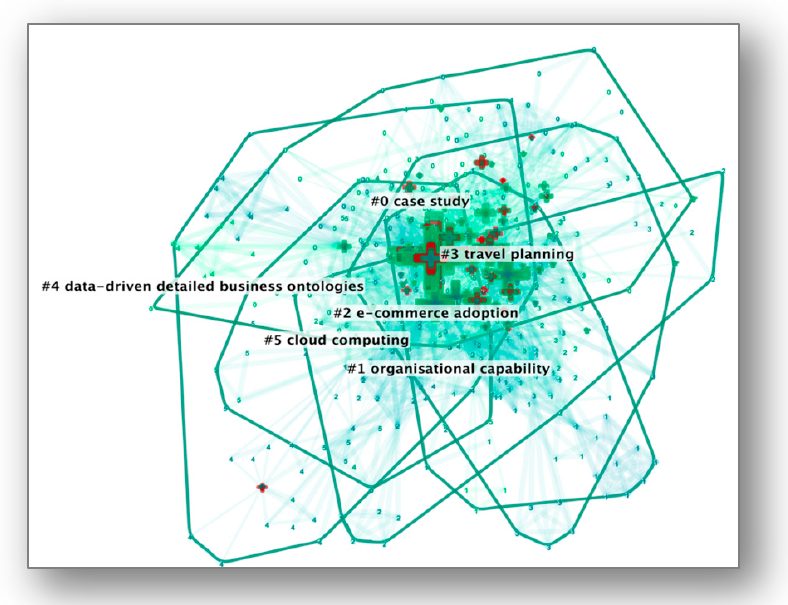
Figure 4. Cluster mapping by keyword node was performed (electronic commerce).